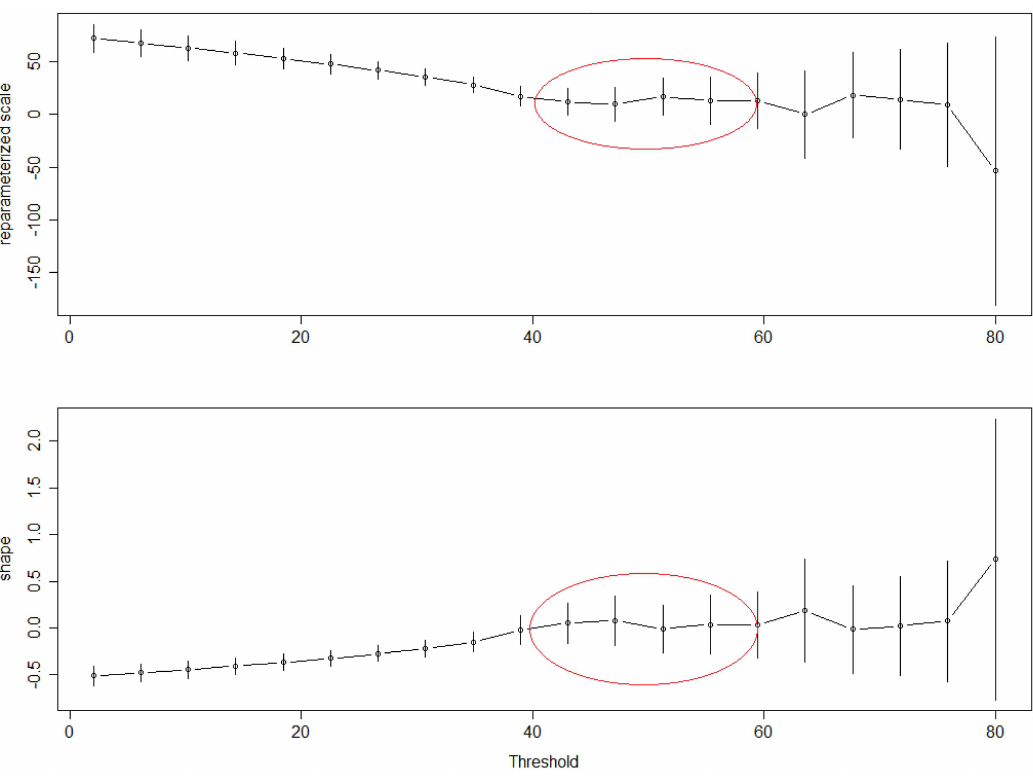
Figure A9. Parameter estimates against threshold for daily rainfall data at Pénéssoulou station.